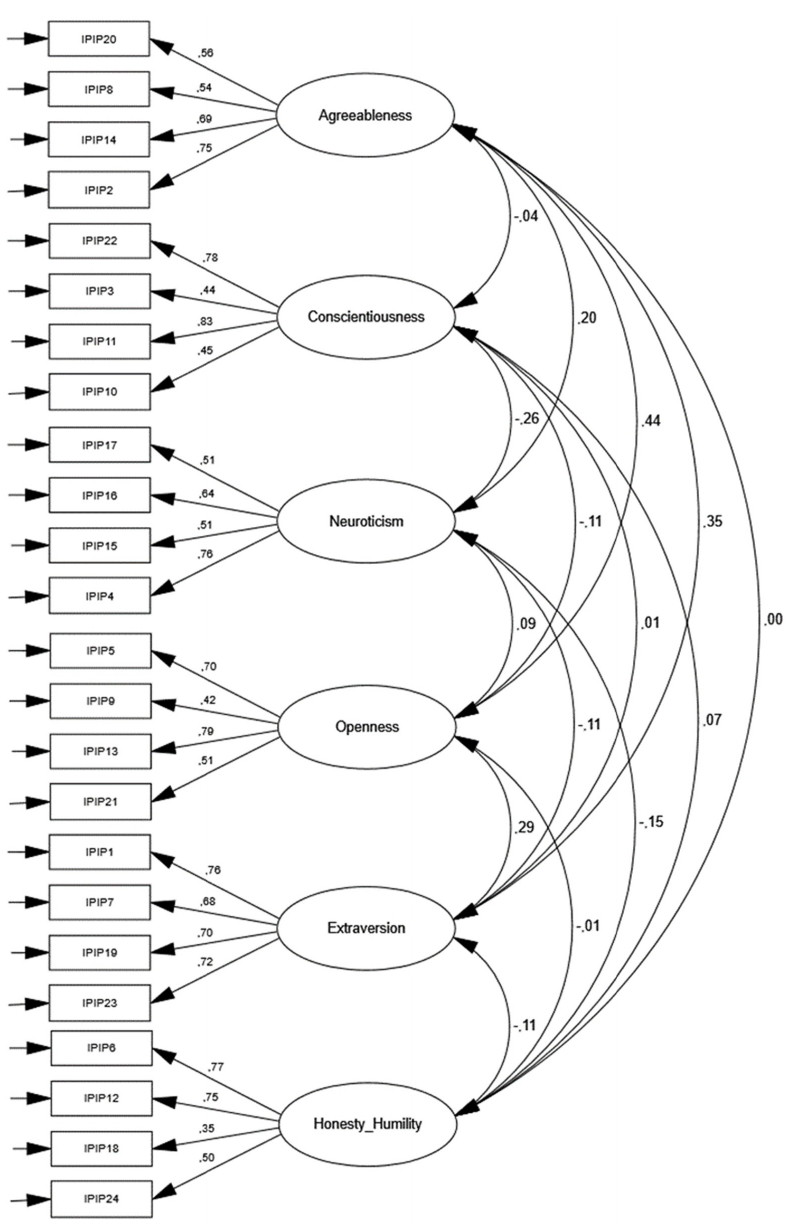
Figure 1. CFA of Mensa sample (N = 353). For item labels, see Sibley et al.